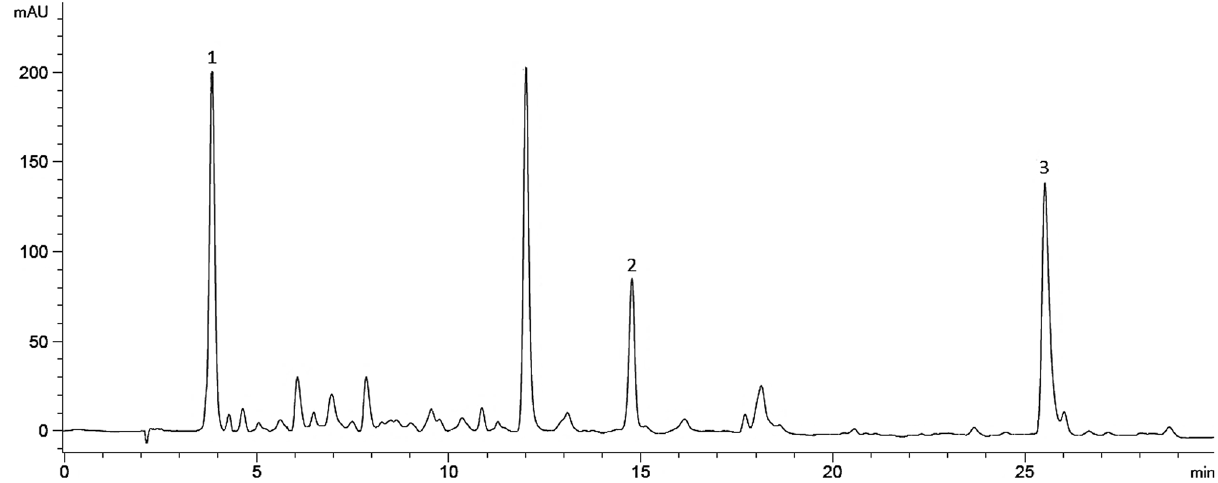
Figure 4. Chromatographic profile for the fourth fraction of L2 validated scale-up extract. Gallic acid (1), corilagin (2), ellagic acid